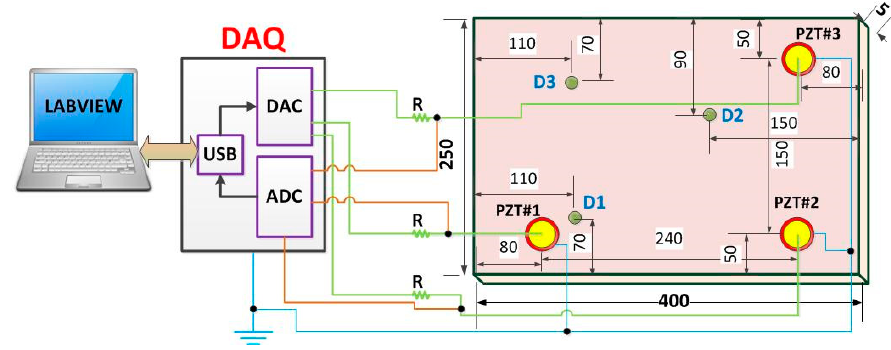
Figure 5. Acquisition system along with the plate, PZT and damage positions (dimensions in mm).